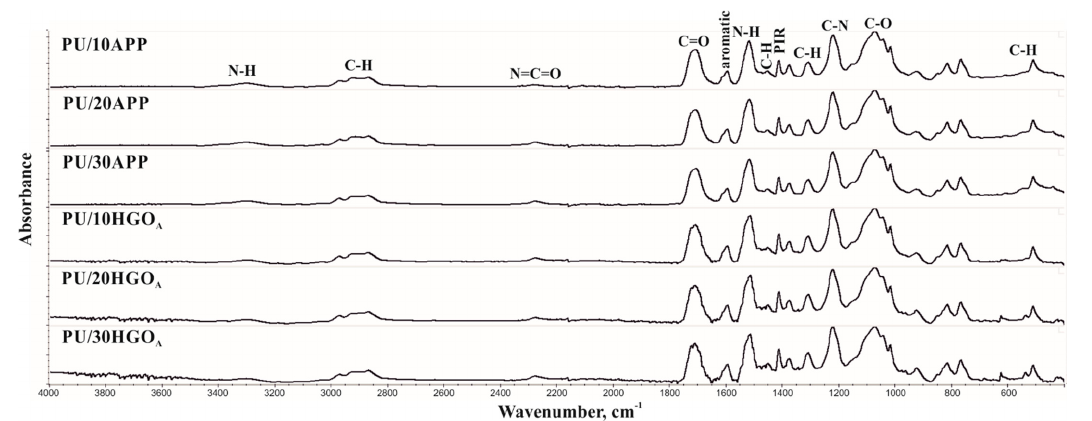
Figure 4. FT-IR spectra of PU/APP and PU/HGO A foams.